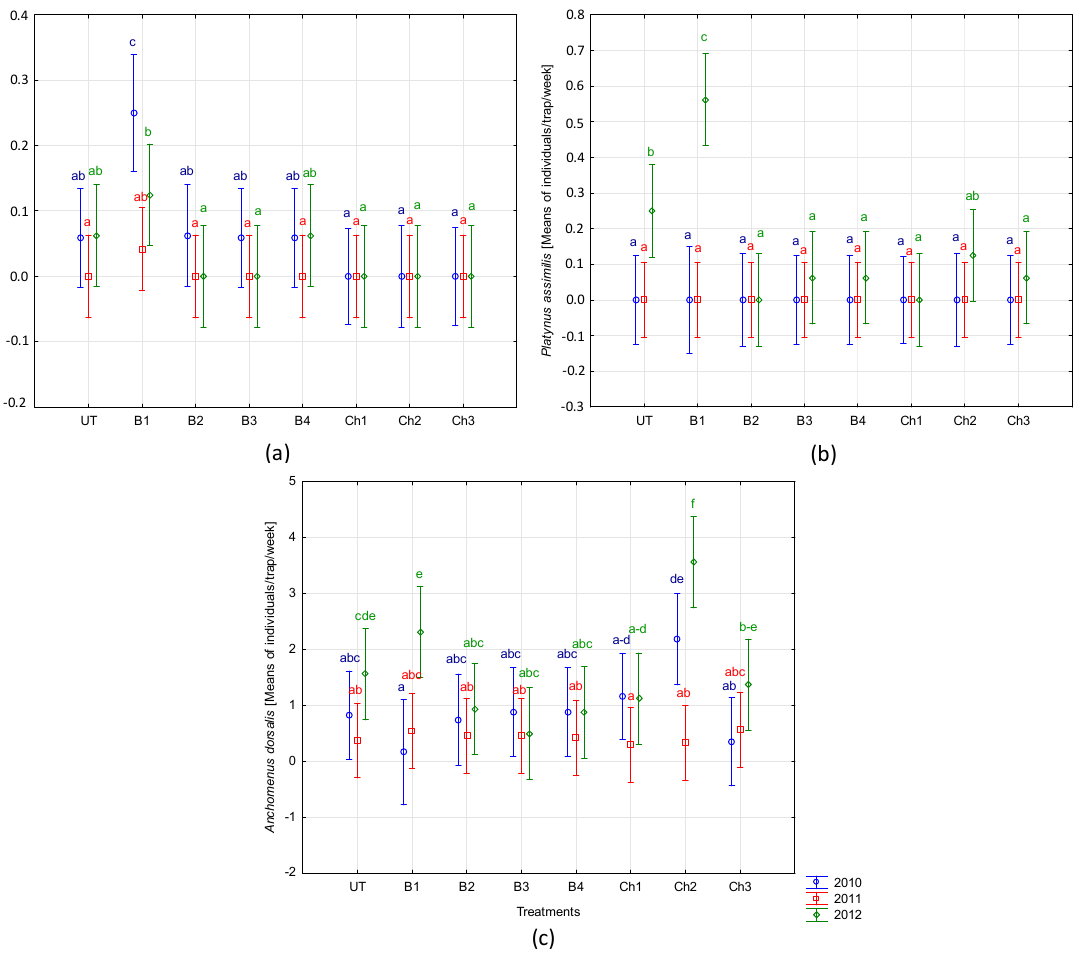
Figure 4. Number of trapped individuals of ( a ) Amara aenea , ( b ) Platynus assimilis , and ( c ) Anchomenus dorsalis in broad bean crop depending on the protection method used: Treatments are the same as in Table 1. Vertical bars denote 0.95 confidence intervals. Means followed by the same letters are not significantly di ff erent according to the LSD test ( p < 0.05), factors: year × protection method. Table 4. Results of the statistical analysis of the presence of selected Carabidae species (other results are presented in Table S2). SS —sum of squares, df —degrees of freedom, MS— mean squares, F — Fisher-Snedecor’s test, p —probability level. Effects SS df MS F p